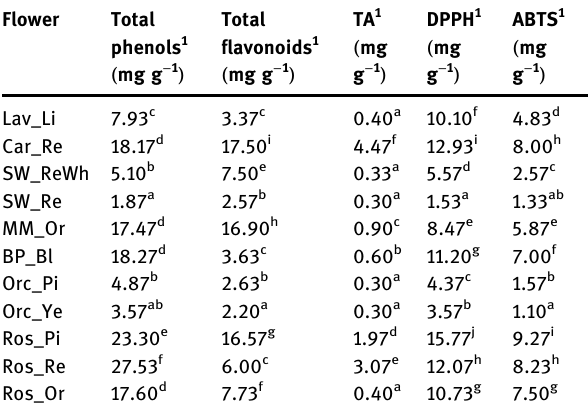
Table 2: Phenolic compounds and AOA of the fl owers analysed Flower